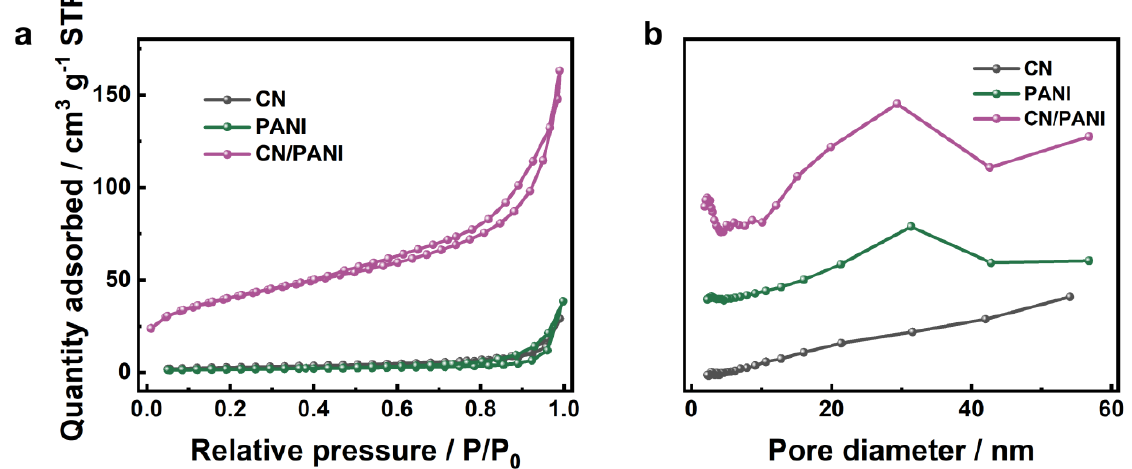
Figure 5. ( a ) N 2 adsorption–desorption isotherms of the pristine CN, PANI, and CN/PANI hetero- junction film. ( b ) The corresponding pore size distributions calculated from BJH method.